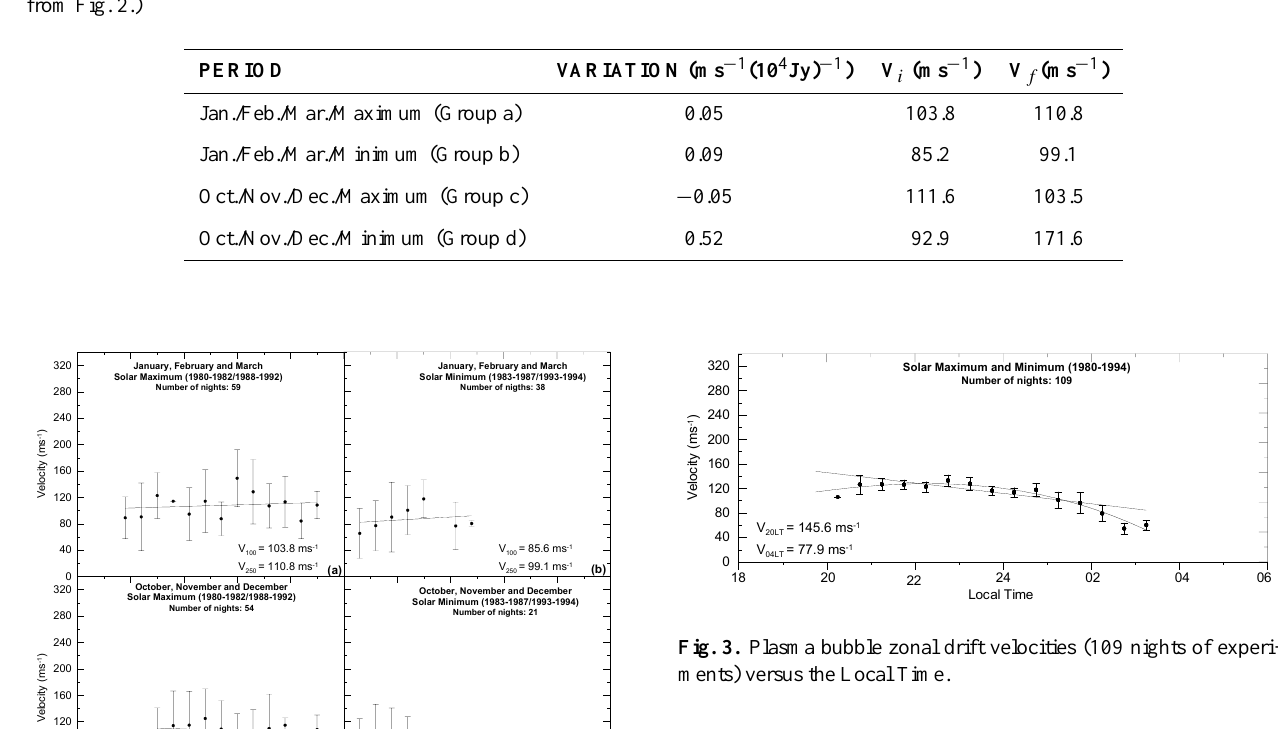
Figure 3. Plasma bubble zonal drift velocities (109 nights of experiments) versus the Local Time.